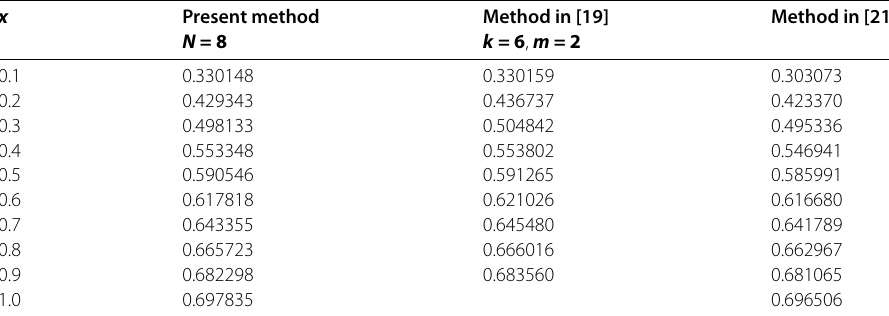
Table 2 Comparison of the numerical solutions with the other methods for α = 2/4 of Example 2